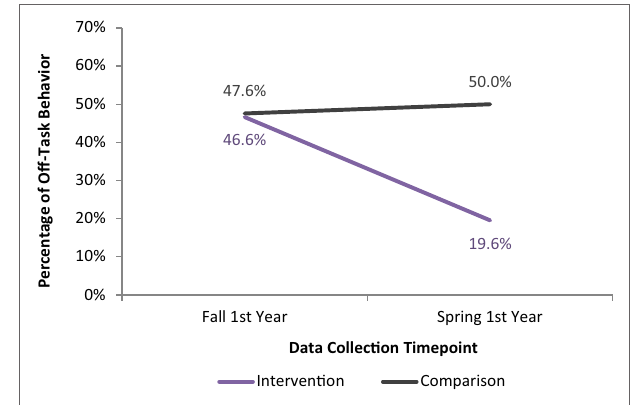
FigUre 3 | Mean percentage of off-task behavior in the fall and spring of the first year that the intervention and comparison groups were in the